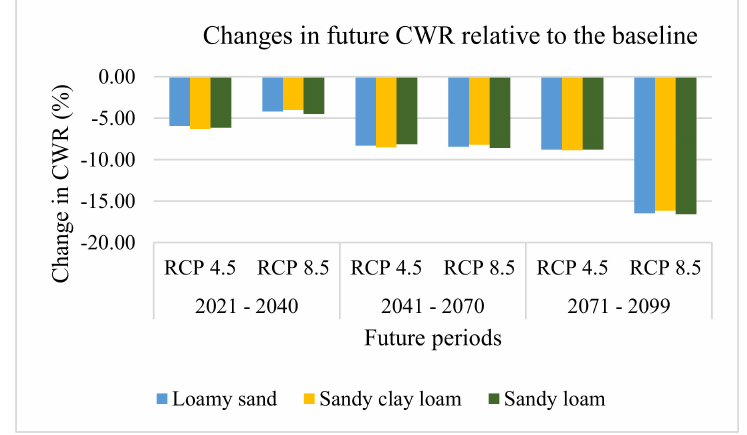
Figure 9. Temporal changes in future crop water requirement (CWR) under RCPs 4.5 and 8.5 (2021–2099) relative to the baseline (1986–2015).